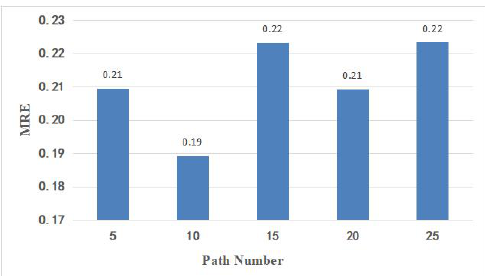
Figure 18. MRE with a varying quantity of paths